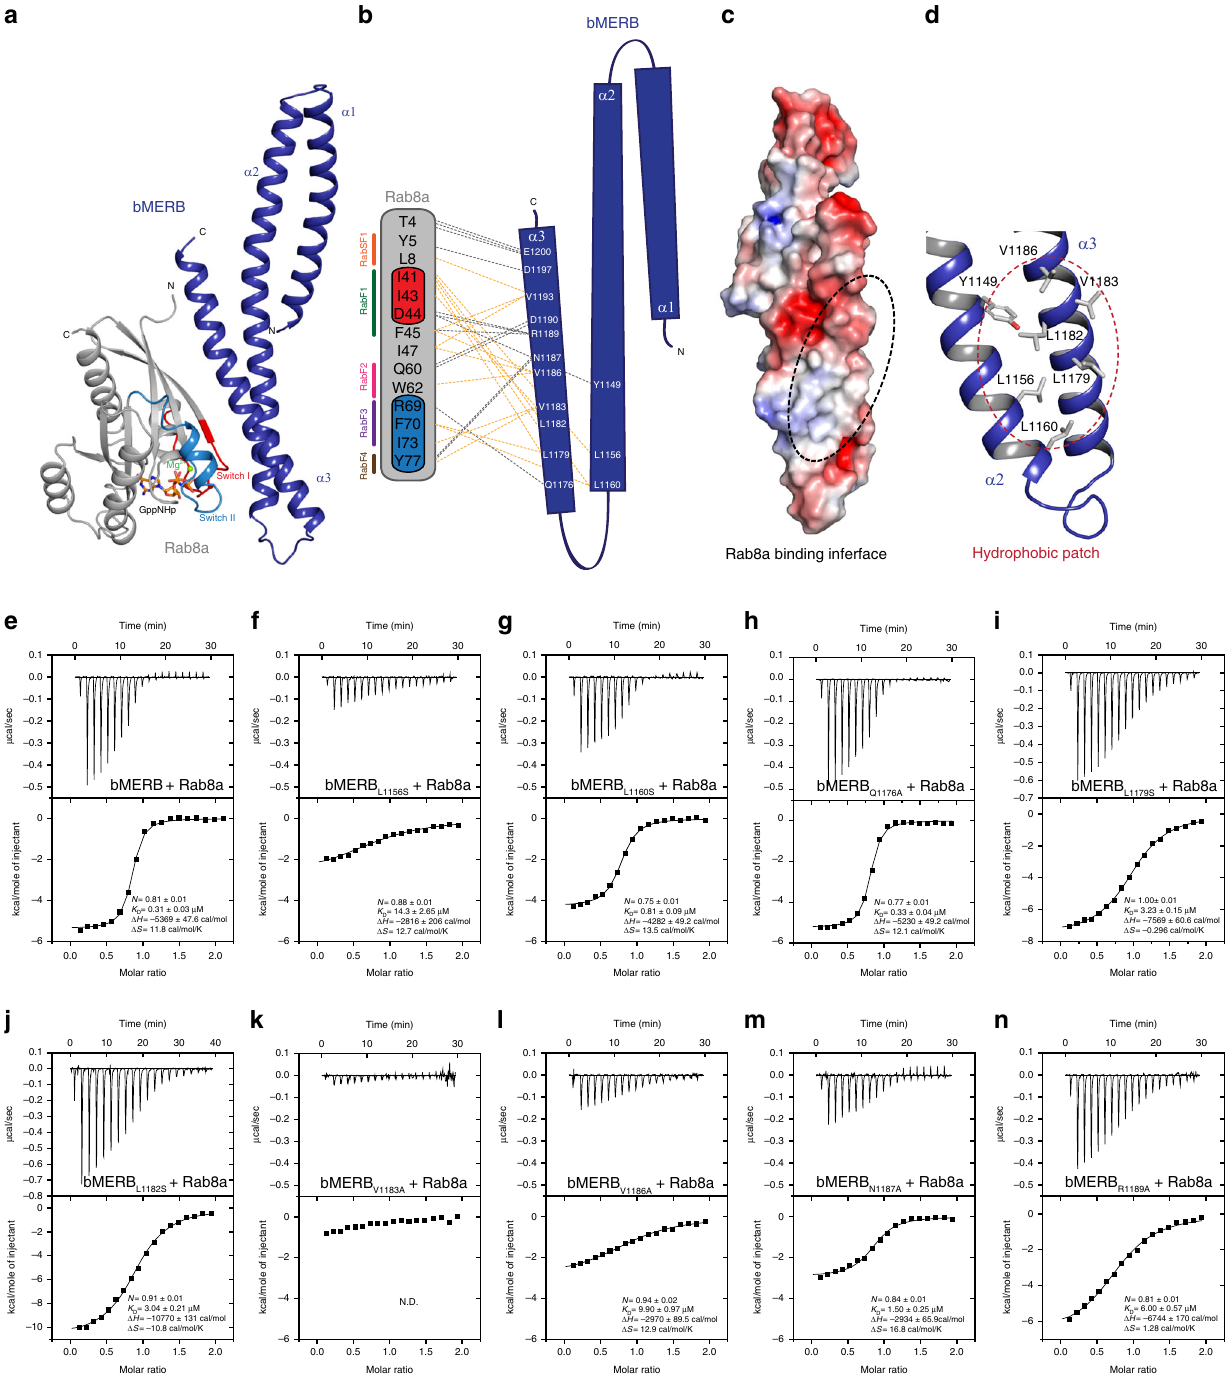
Fig. 6 The C-terminal hydrophobic patch of the bMERB domain is crucial for Rab8a interaction. a Cartoon depiction of the EHBP1 bMERB M1116A : Rab8a GppNHp complex. Rab8a GppNHp (gray, chain B) binds to EHBP1 bMERB (blue, chain D) via its N-terminal regions, the switch regions as well as the inter-switch region. Switch I and switch II are shown in red and blue, respectively. GppNHp and Mg 2 + are depicted as sticks and a green sphere, respectively. b Schematic illustration of the interactions between the bMERB domain and Rab8a GppNHp . Hydrogen bonds and ionic interactions are shown in gray dashed lines and light orange dashed lines indicate hydrophobic interactions. RabSF1, RabF1, RabF2, RabF3, and RabF4 motifs are shown in orange, green, pink, purple, and brown respectively. c Electrostatic potential of the bMERB domain calculated in PyMOL using the APBS-PDB2PQR plugin and visualized in red to blue ( − 5 kT/e to + 5 kT/e). The dashed line highlights the region that interacts with Rab8a. d The C-terminal hydrophobic patch of the EHBP1 bMERB domain. e – n Mutational characterization of the bMERB:Rab8a complex interface. Binding of GppNHp Rab8a 1-176 with different EHBP1 bMERB mutants was systematically tested and af fi nities were measured by ITC experiments. The data are representative of at least three repetitions. N.D. denotes not